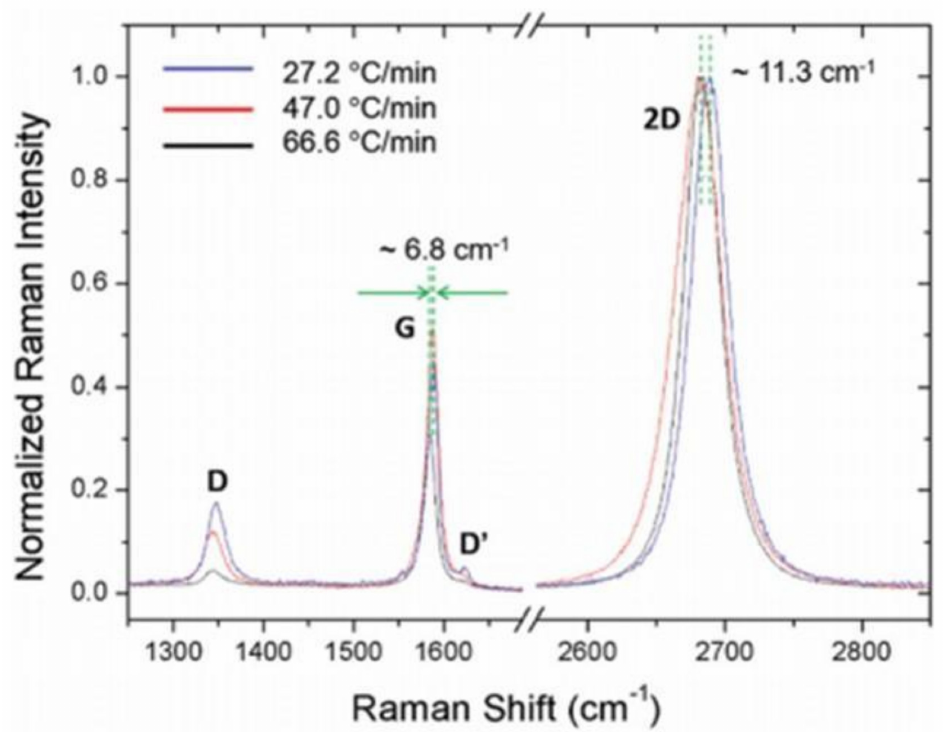
Figure 15. Representative Raman spectra were displayed for each cooling rate with graphene band assignments. The lowest cooling rate with blue spectrum and the highest cooling rate with black spectra of each G and 2D peak were indicated as red-shift from 27.2 ◦ C/min to 66.6 ◦ C/min of each G and 2D band was ~6.8 cm − 1 and ~11.3 cm − 1 , respectively. Reprinted with permission from ref.